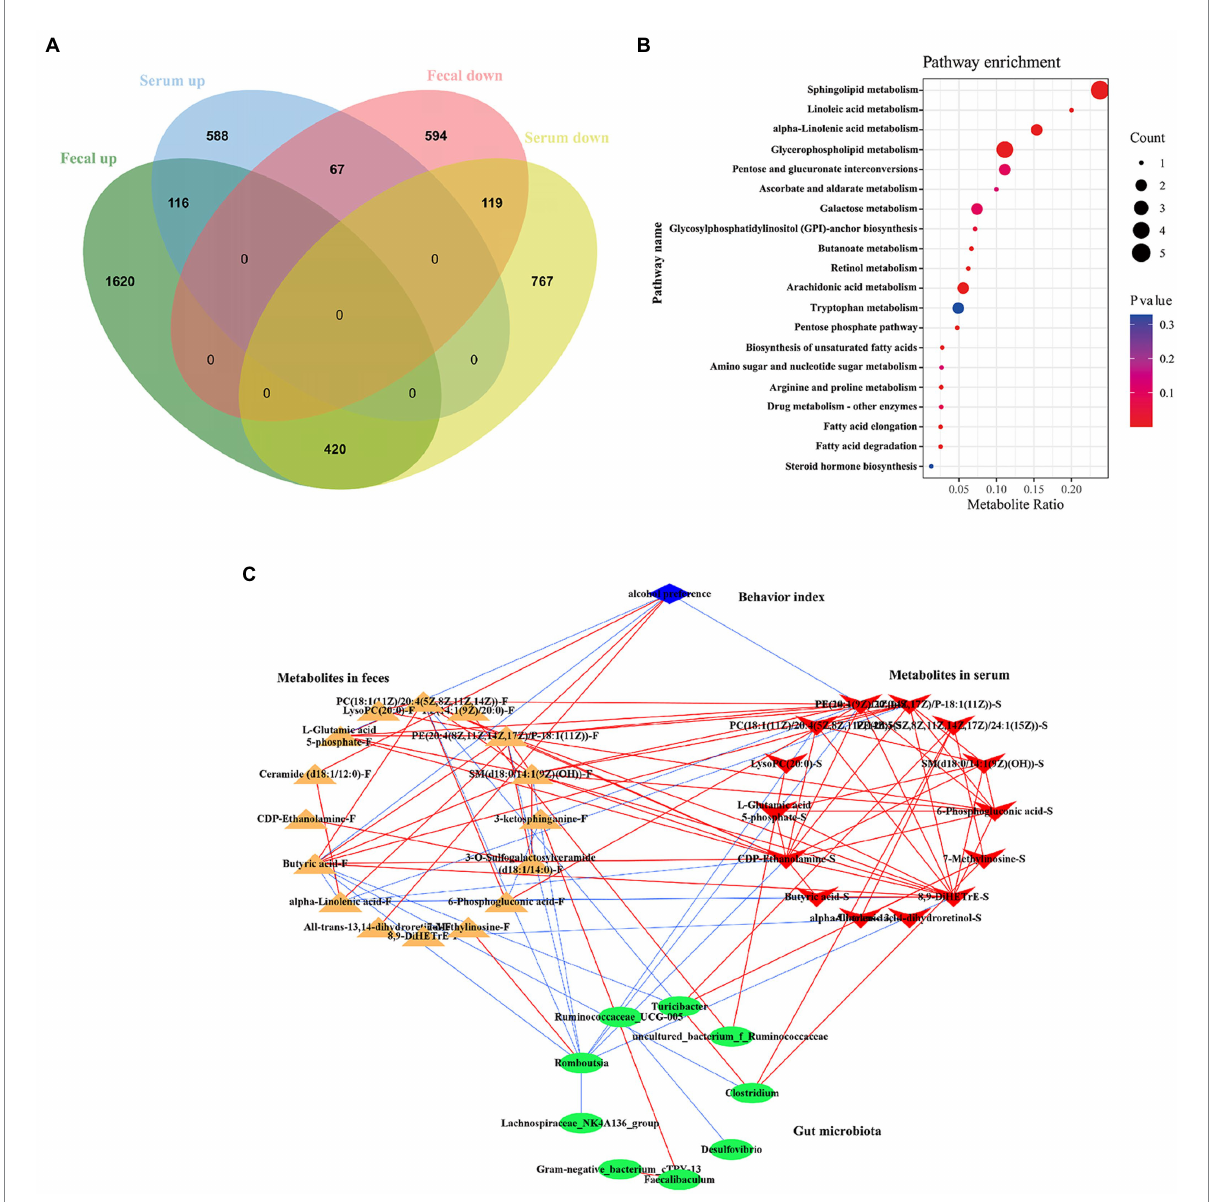
FIGURE 13 Correlations of gut microbiota with the co-regulated metabolites in feces and serum in AUD rats. The Venn diagram showed the co-regulated metabolites in feces and serum (A) . The enrichment pathway of co-regulated metabolites by KEGG analysis (B) . Network analysis among the AUD behavior, gut microbiome and co-regulated metabolites (C) , the red line represented the positive correlation, the blue line represented negative correlation, | r | > 0.8, p <